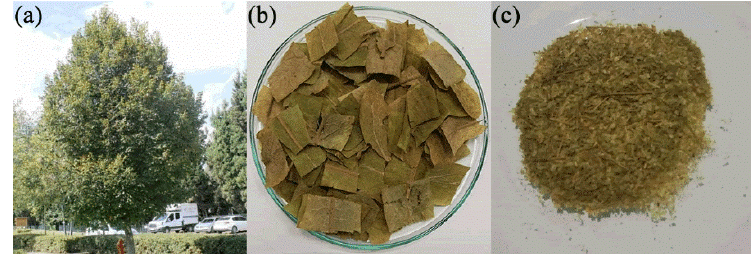
Figure 1. Linden leaves: fresh leaves ( a ), dry samples ( b ), and powder ( c ).